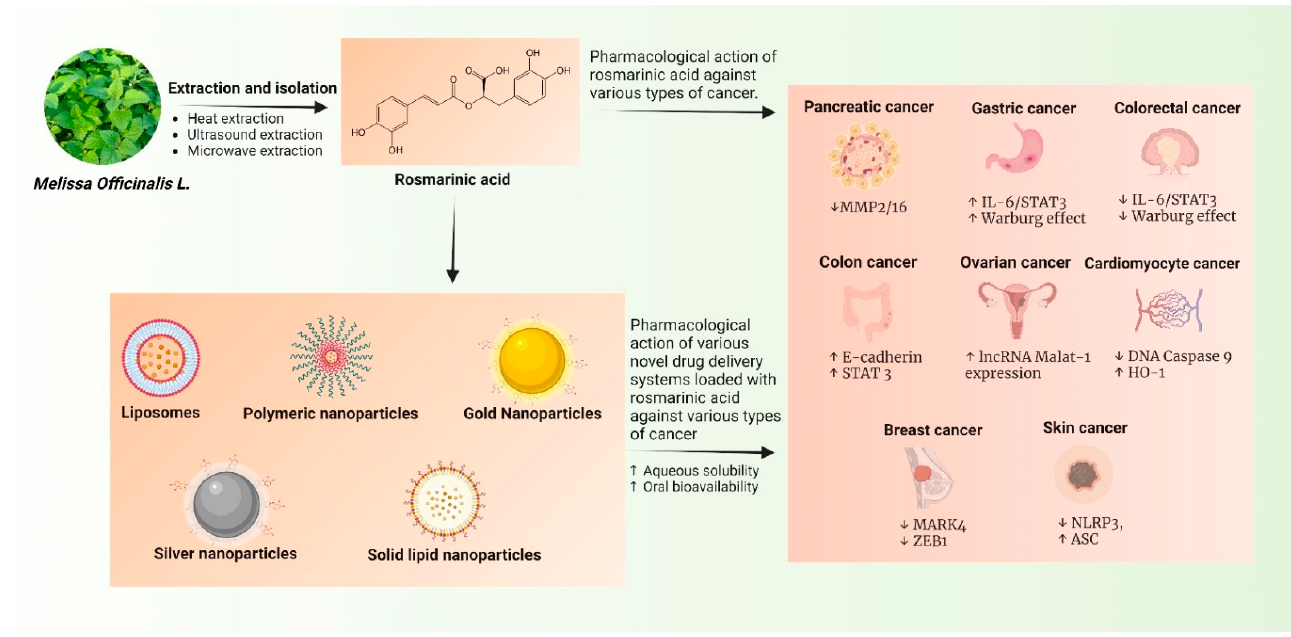
Figure 6. Schematic representation of entire flow diagram of review highlighting the process of extraction, isolation, and anticancer activities of naïve rosmarinic acid and its nanocarriers. ↑ indicates upregulation and symbol ↓ indicates downregulation.